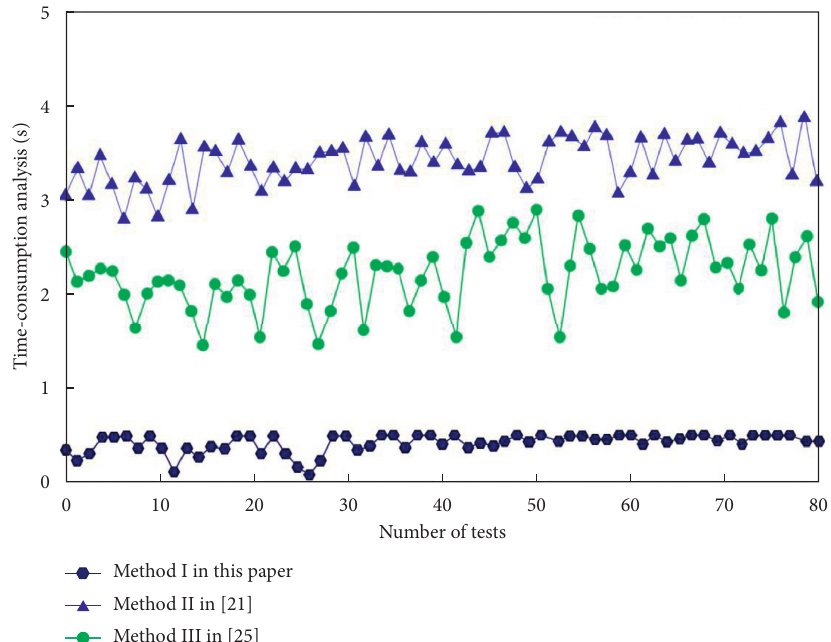
Figure 6: The time-consumption comparison of damage evaluation by methods I, II, and